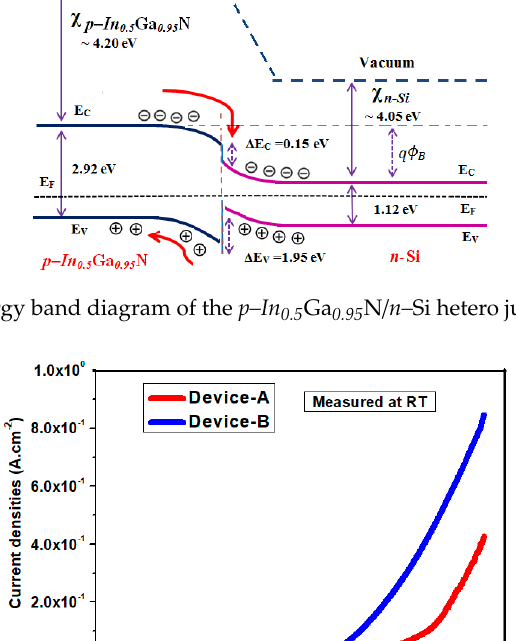
Coatings 2019 , 9 , x FOR PEER REVIEW 4 of 10